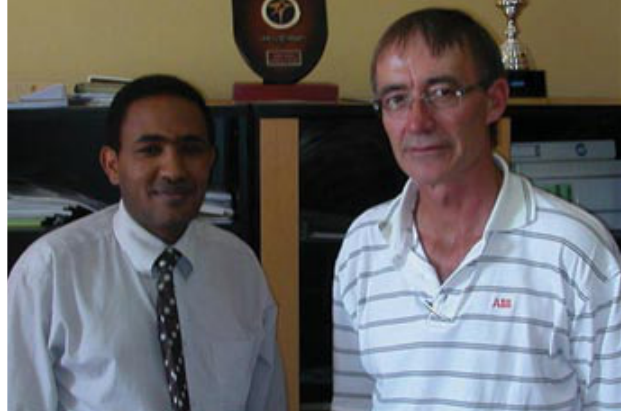
Figure 9 The Dean of Health Sciences, Dr Assefa and